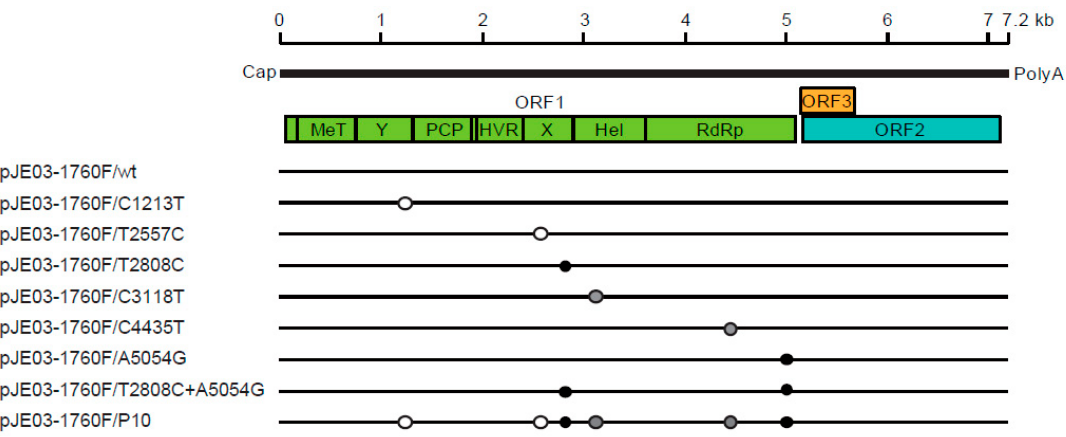
Figure 3. Positions of mutations in the eight recombinant cDNA clones of the JE03-1760F strain. Upper panel: the genomic structure of HEV. Abbreviations: MeT, methyltransferase; Y, Y domain; PCP, papain-like cysteine protease; HVR, hypervariable region; X, X domain; Hel, helicase; and RdRp, RNA-dependent RNA polymerase. Lower panel: the open circles denote synonymous mutations without structural changes in HEV RNA, the shaded circles denote synonymous mutations with structural changes in HEV RNA and the closed circles denote non-synonymous mutations. Modified from Nagashima et al. [187].